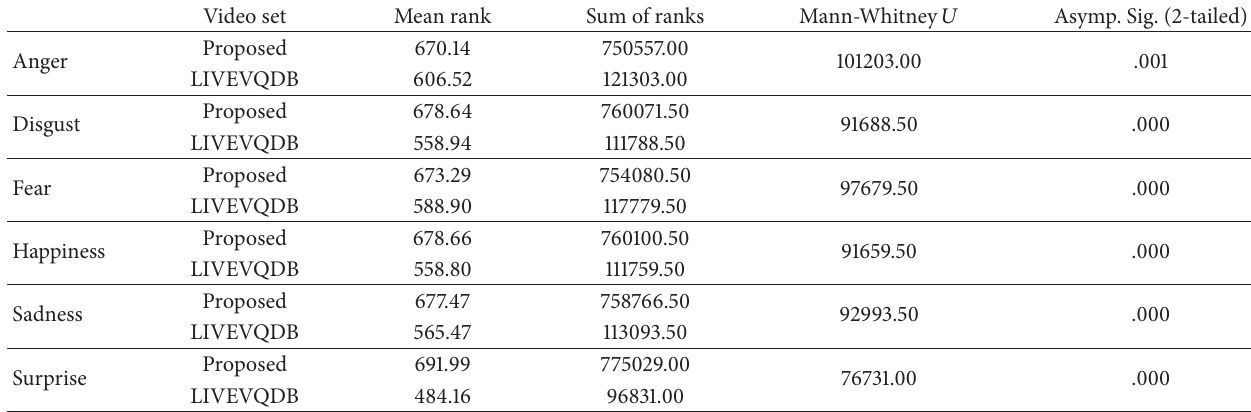
Table 4: Comparison of affective dimensions by the two